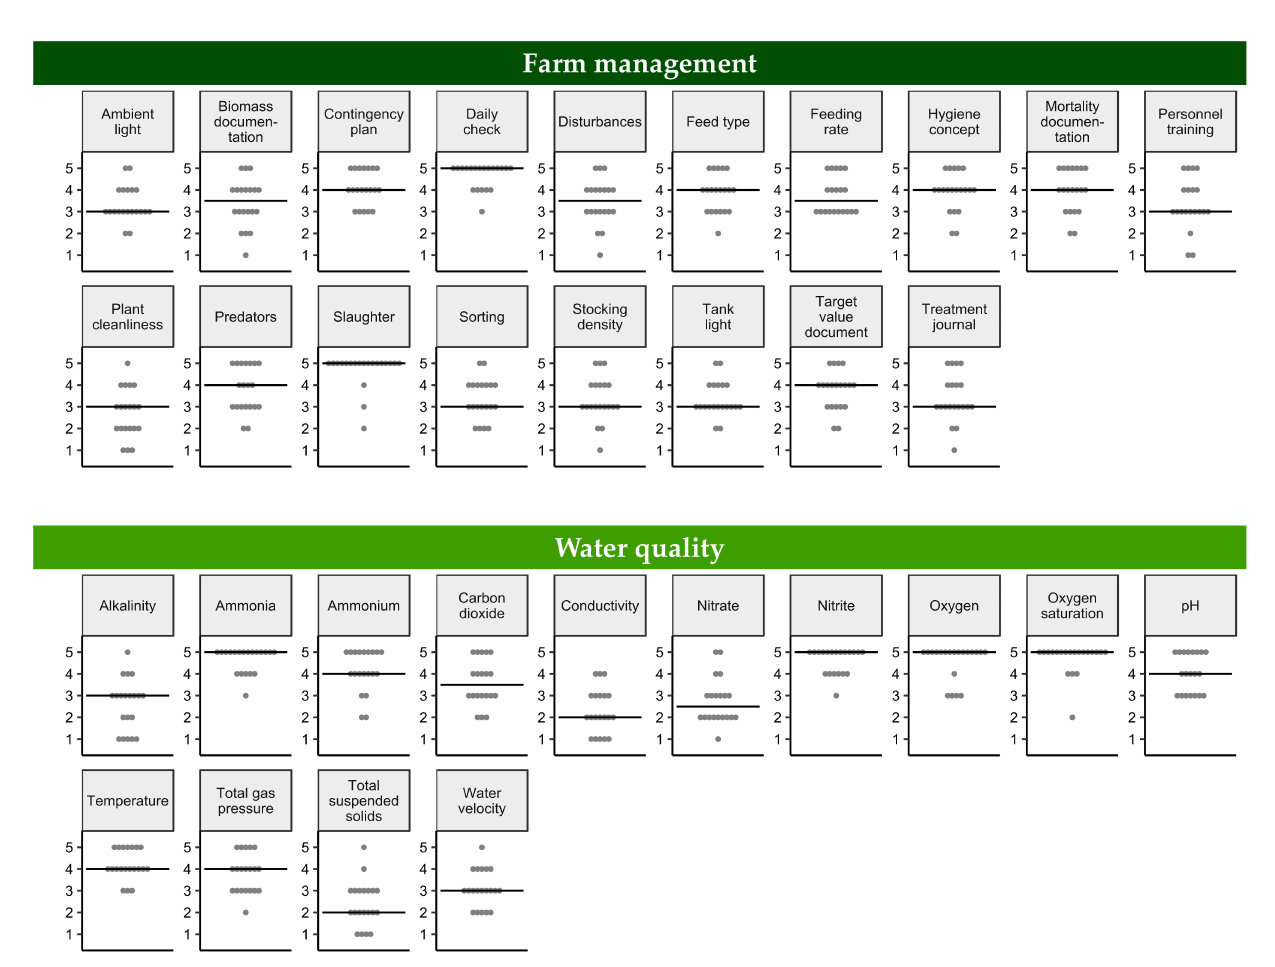
Figure A1. Results of the expert survey for the modules farm management and water quality